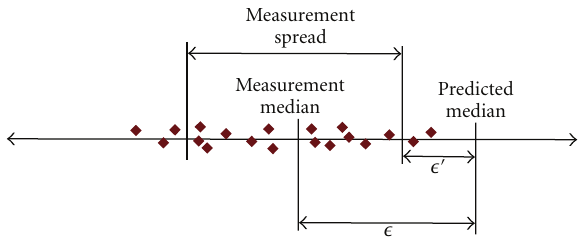
Figure 6: Schematic explaining error ( (cid:2) ) and spread corrected error ( (cid:2) (cid:5) ) in terms of measurement spread and measured and predicted median